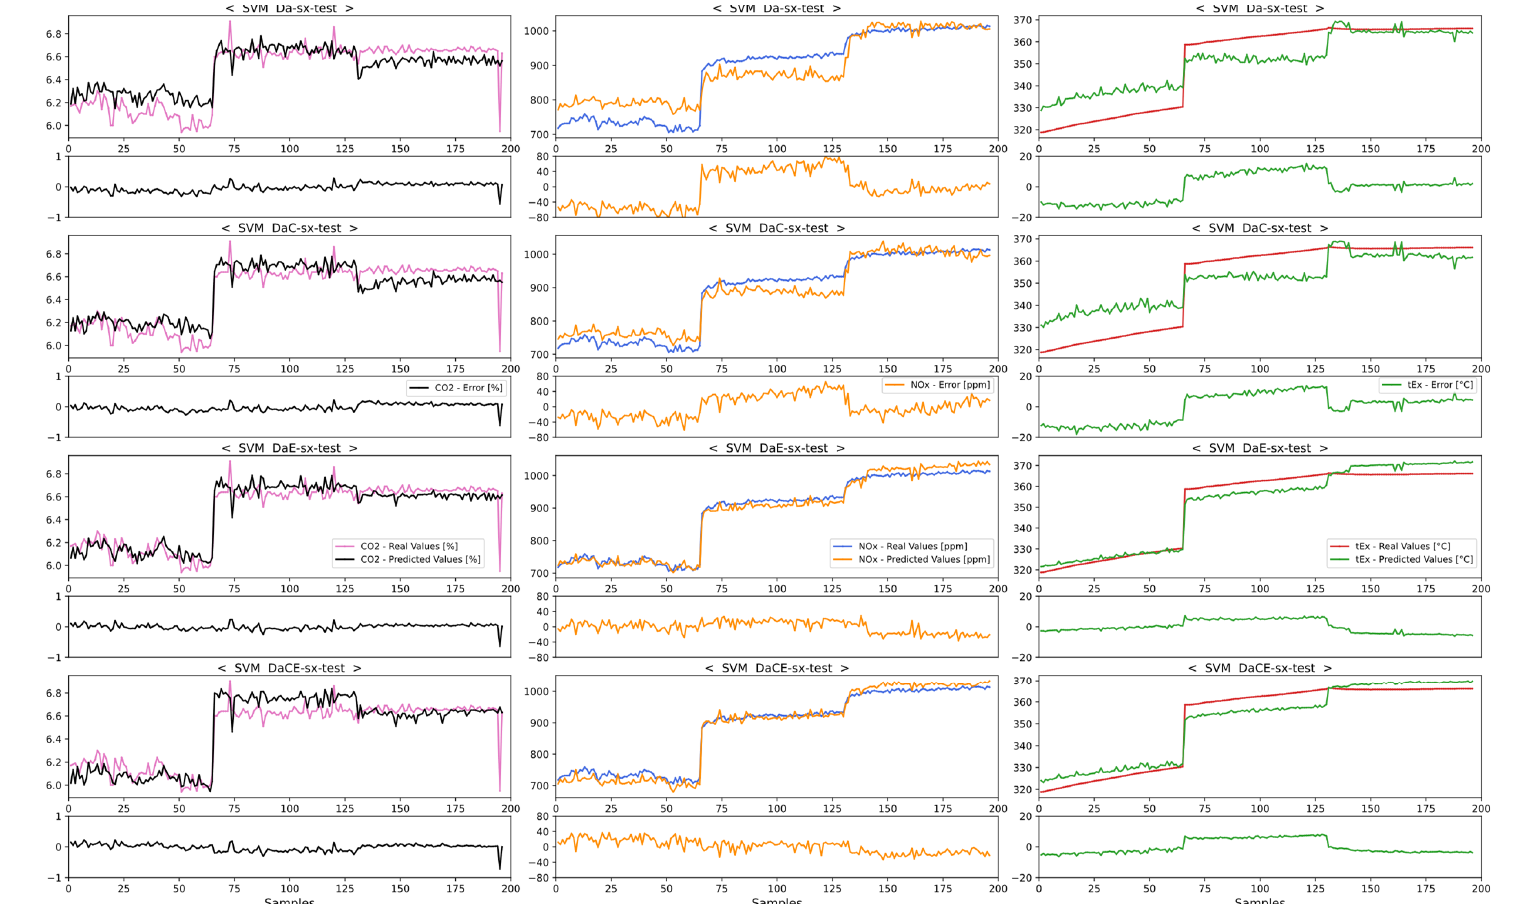
Figure 11. Comparison of real and predicted values for different datasets with SVM models in no ‐ SCR mode.